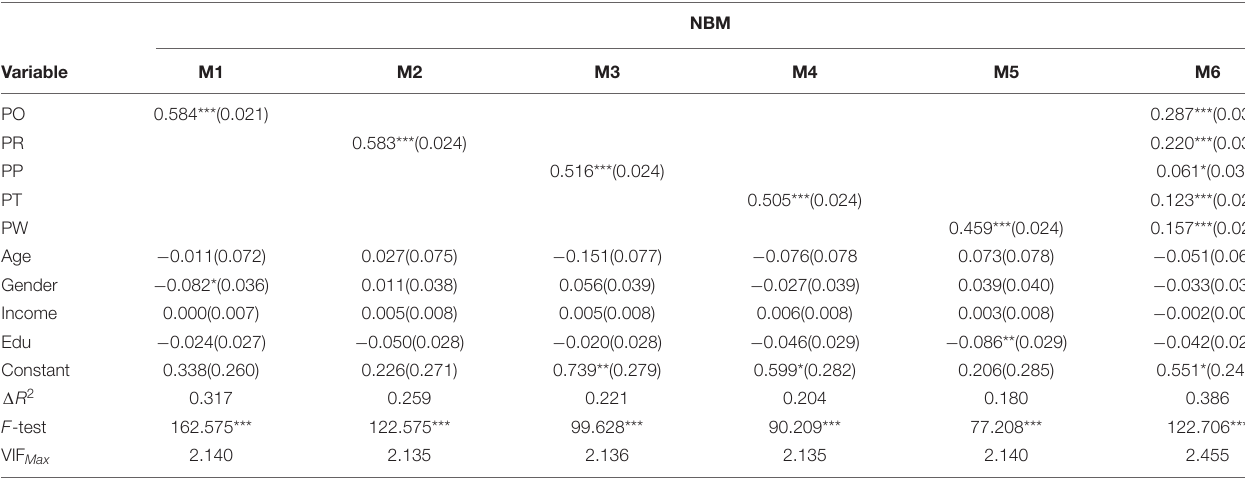
TABLE 2 | Consumer purchase behavior changes and novelty-centered business model